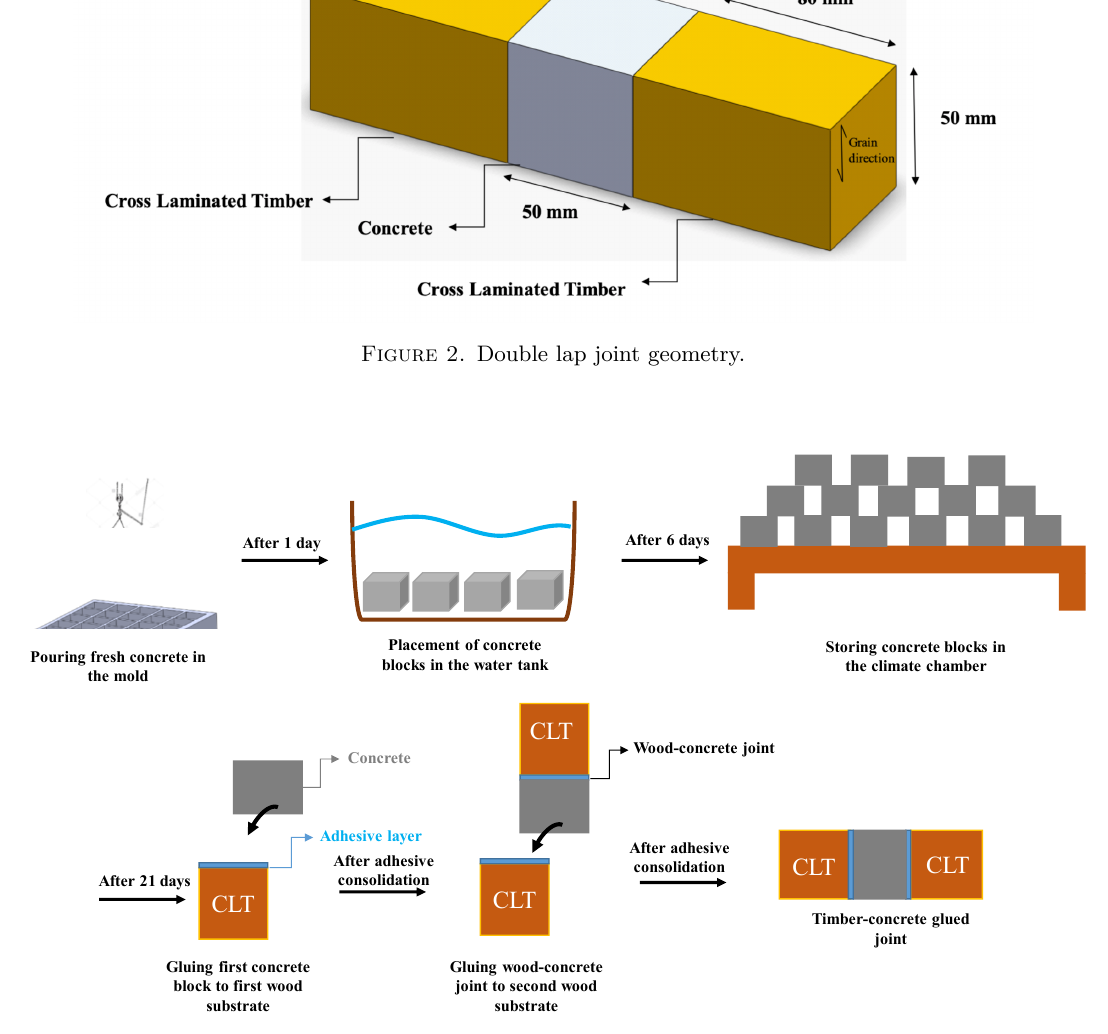
Figure 3. Procedure of dry bond